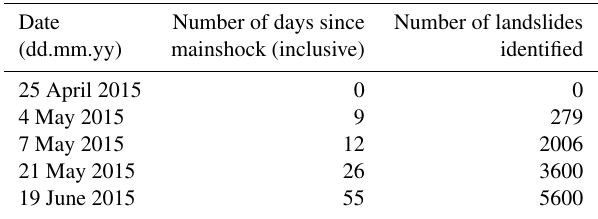
Table 1. Total number of landslides identified by date by the joint DU–BGS group following the 2015 Gorkha